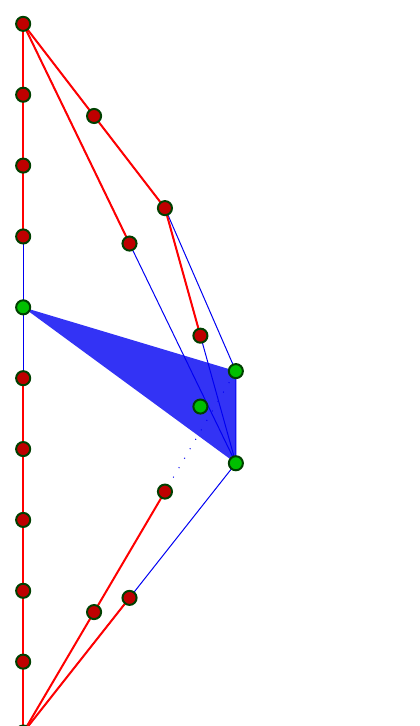
(a) Re(cid:13)exive section dividing polytope into E 7 - (b) Re(cid:13)exive section dividing polytope into and E 8 -top. SO(28)- and trivial-top. Figure 1. The two di(cid:11)erent re(cid:13)exive sections through the (dual) polytope de(cid:12)ned via equation (2.4) and (2.5), respectively. The red dots indicate toric divisors which correspond to the resolution divisors of the E 7 , E 8 , and SO(28) gauge groups. Divisors which intersect each other lie next to each other along the red edges. Note the appearance of the extended Dynkin diagram structure. Furthermore, the SU(2) of Spin(28) (cid:2) SU(2) = Z 2 on the right hand side is given by the divisor corresponding to the green interior point on the edge of the re(cid:13)exive